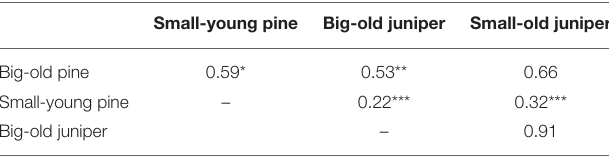
TABLE 1 | Post-hoc multiple comparisons of xylem phenology between groups conducted by orthogonal